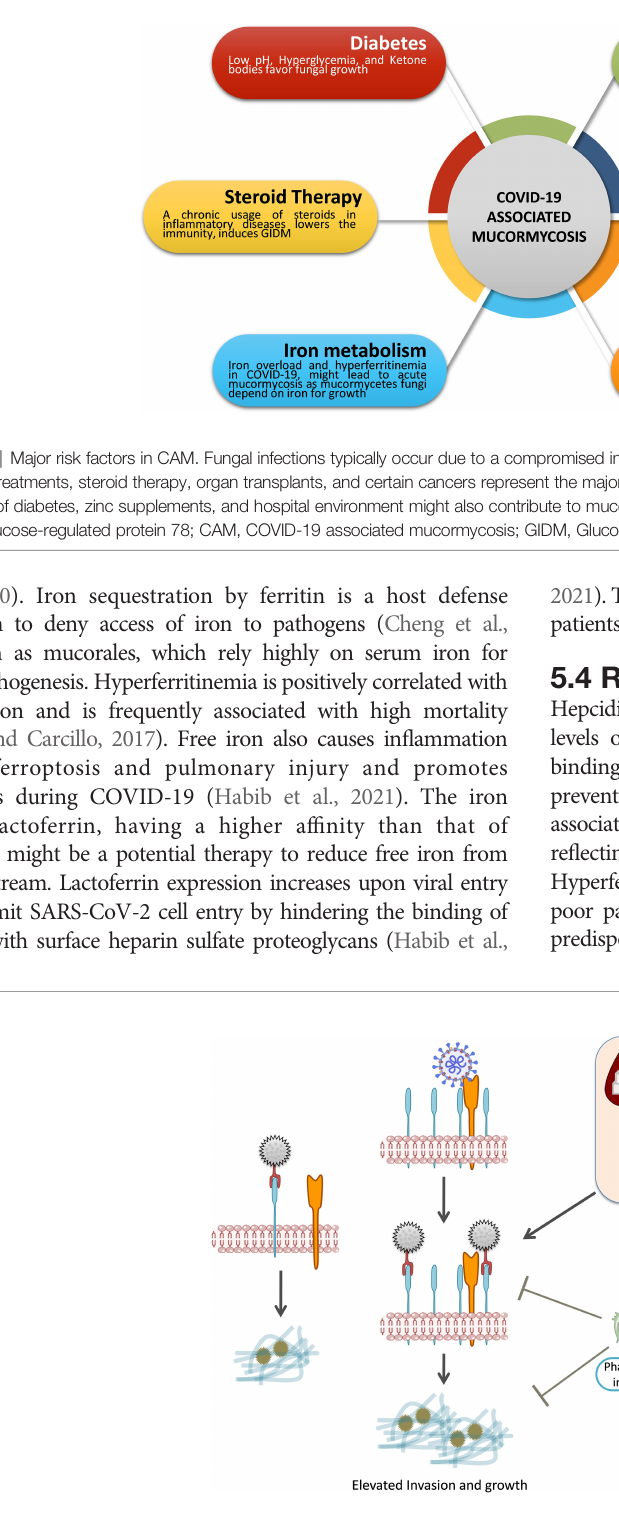
FIGURE 3 | GRP78, COVID-19, and mucormycosis. Mucorale fungi utilize GRP78 receptor for host cell invasion. SARS-CoV-2 infection increases the expression of GRP78 and hence might promote mucormycosis. Diabetic ketoacidosis and steroid usage are also known to upregulate GRP78 expression. GRP-78, glucose-regulated protein 78; SARS CoV-2, Severe acute respiratory syndrome coronavirus 2; Ace 2, Angiotensin-converting enzyme 2; CotH3, spore coat protein homolog